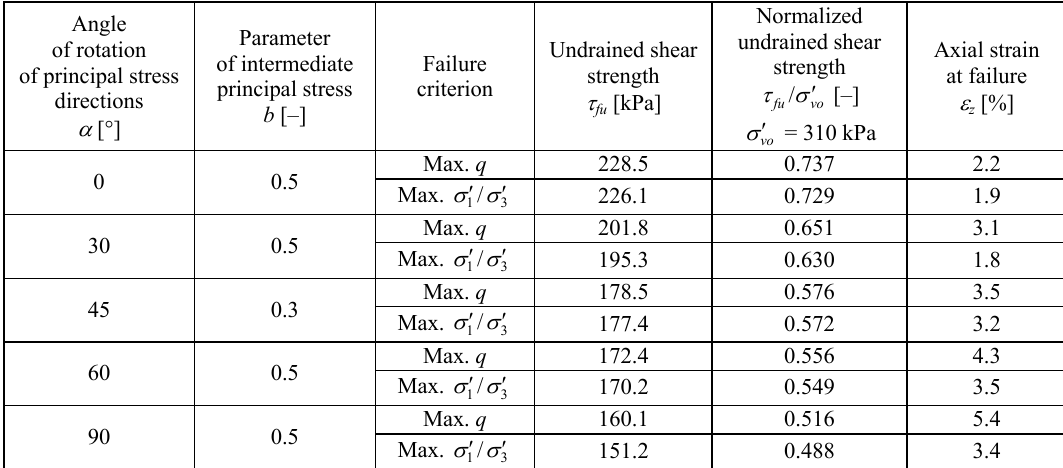
Table 2. Results of the HCA test for clay [12]